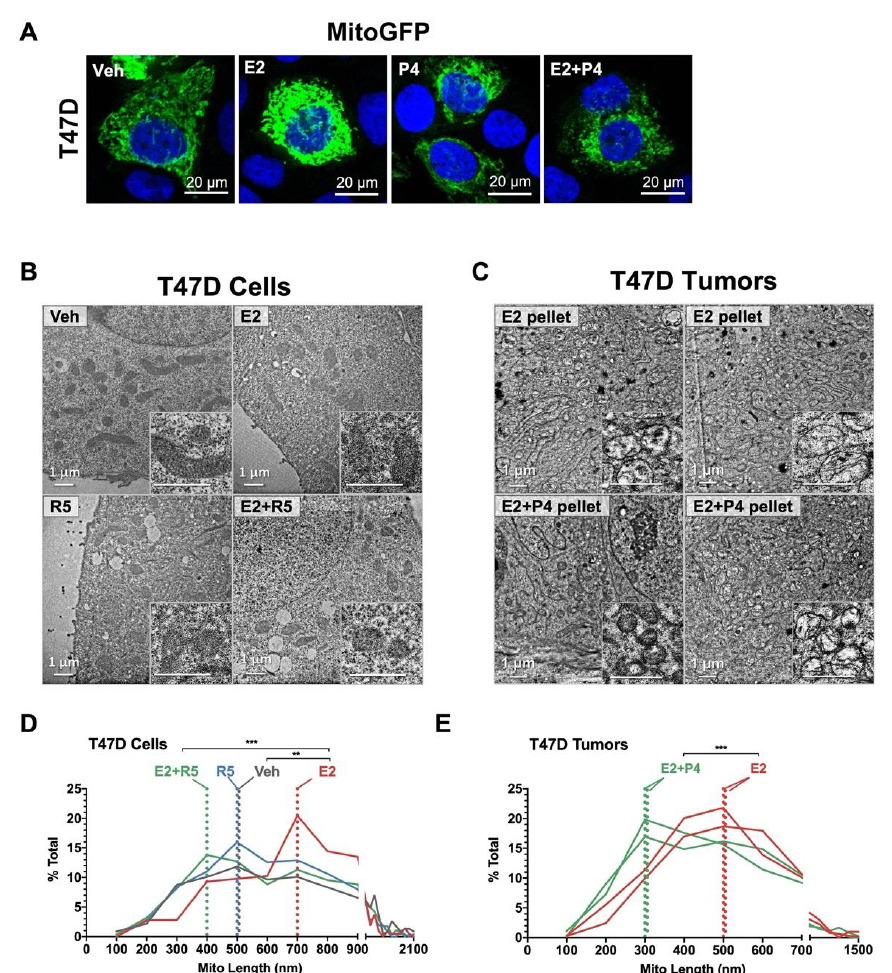
Figure 5. Estrogens elongate while progestins blunt alter mitochondrial length. ( A ) MitoGFP: representative fields from laser scanning confocal images at 40X magnification in T47D cells treated with estradiol (E2, 10 − 8 M), progesterone (P4, 10 − 8 M), combination (E2 + P4, 10 − 8 M each), or ethanol (Veh) for 48 h then labeled overnight with CellLights BacMam 2.0 MitoGFP. Cells were fixed in paraformaldehyde, counterstained with DAPI, and mounted on coverslips. Images were collected using confocal laser scanning microscopy (Zeiss LSM 780) with 40X objective. ( B ) Cultured T47D cells treated with estradiol (E2, 10 − 8 M), promegestone (R5, 10 − 8 M), combination (E2 + R5, 10 − 8 M each), or ethanol (vehicle) for 24 h were fixed, sectioned, and imaged using transmission electron microscopy. A representative image set is presented for each cell line and treatment (top). ( C ) T47D xenograft tumors (2) from mice supplemented with E2 alone or E2 + P4. A representative image set is presented for each tumor and treatment (top). ( D ) Quantitation of mitochondrial length in T47D cells was measured along the longest axis in Fiji in >200 mitochondria across 10–14 fields per treatment. Histograms represent mitochondrial length corresponding to 100-nm bins. T47D cells, mode: E2 + R5 = 400 nm; Veh, R5 = 500 nm, E2 = 700 nm. ( E ) Quantitation of mitochondrial length in T47D tumors (two individual tumors plotted separately) was measured and plotted as in D. T47D tumors, mode: E2 + P4 tumors 1,2 = 300; E2 tumors 1,2 = 500 nm. ** p < 0.01, *** p < 0.001 for the indicated comparisons using Kolmogorov–Smirnov test for frequency distributions comparing hormone